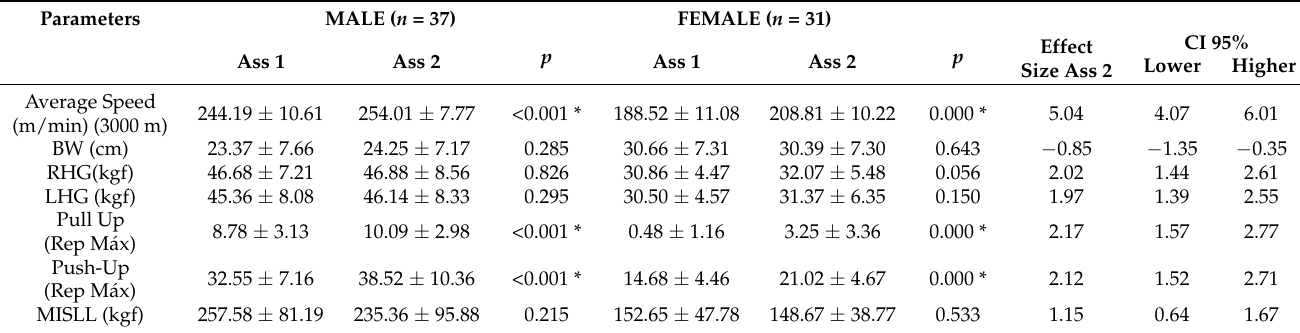
Table 3. Effect of training on physical fitness